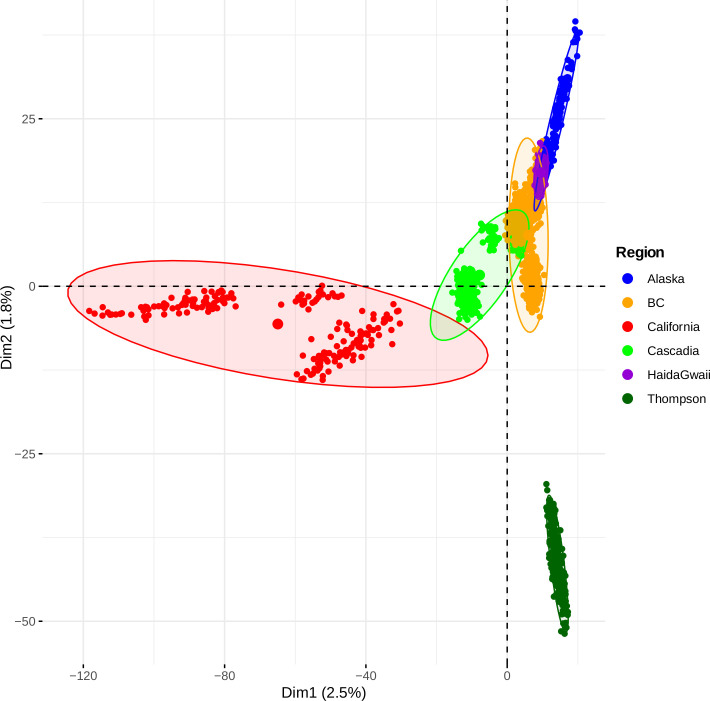
Genetic structure and gene flow.Principal Component Analysis (PCA) summarizing population genetic structure among 1,957 individuals based on the principal component axis 1 and axis 2. Each point represents an individual and the colours represent the major regional groups. The larger point represents the barycentre of each group.